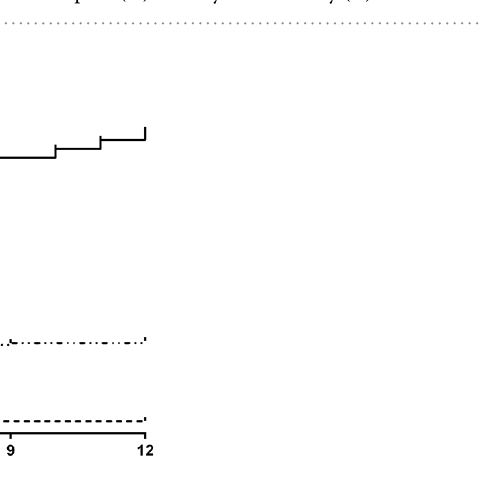
Figure 2. Comparison of areas under the curve for in-hospital ( A ) and 1-year mortality ( B ).